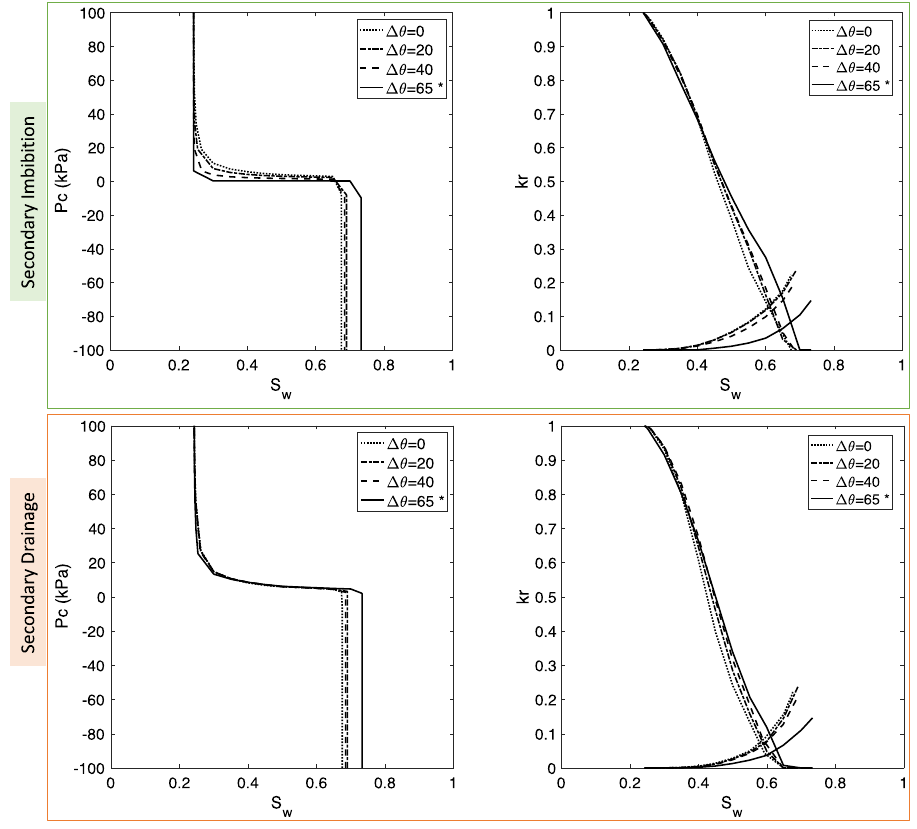
Figure 8. Effect of advancing contact angle on flow properties of H 2 -brine for secondary imbibition. Note ◦ that the receding contact angle is fixed at 21.56 . * indicates the base-case which corresponds to the modified Morrow relationship as shown in Fig. 2.